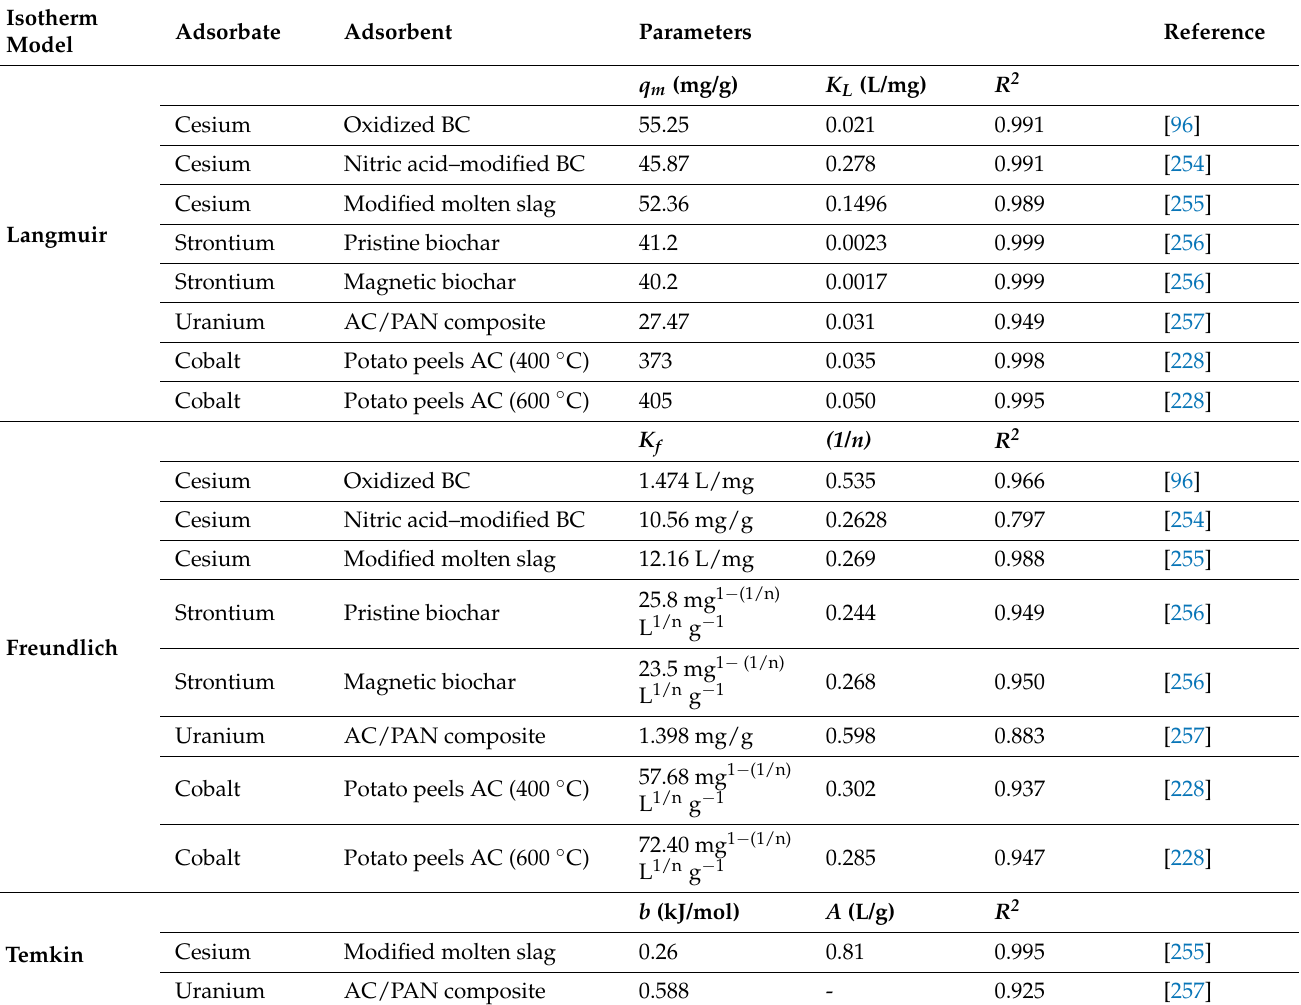
Table 9. Summary of fitted adsorption isotherm model parameter’s value of several